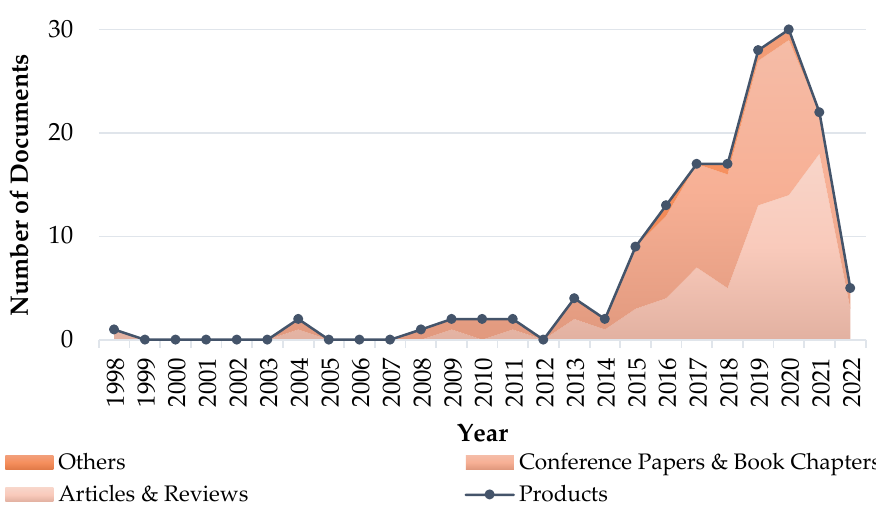
Figure 3. Evolution of documents in time, plotted in stacked fashion. In black dots and connecting lines the cumulative function. Products classes were merged combining articles (74) with reviews (0), and conference papers (73) with book chapters (6). The category Others collects documents classified as Notes (2) and Errata